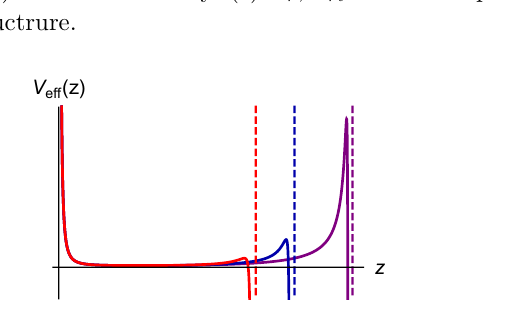
Figure 8. Shape of potential near the horizon. Dashed lines are the event horizons at a few temperatures. As T increases, horizon moves out in z